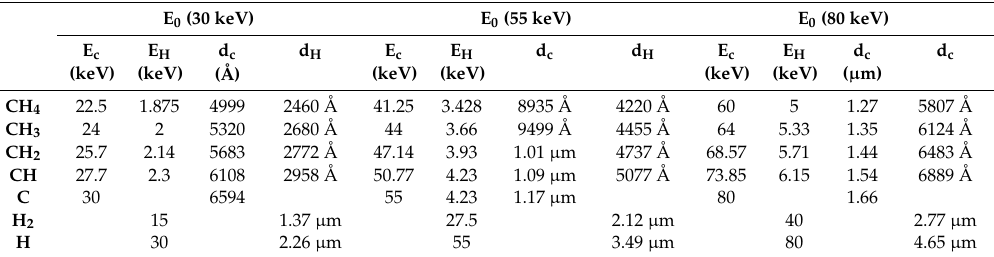
Table 1. The projectiles of carbon (d c ) and hydrogen (d H ) by SRIM